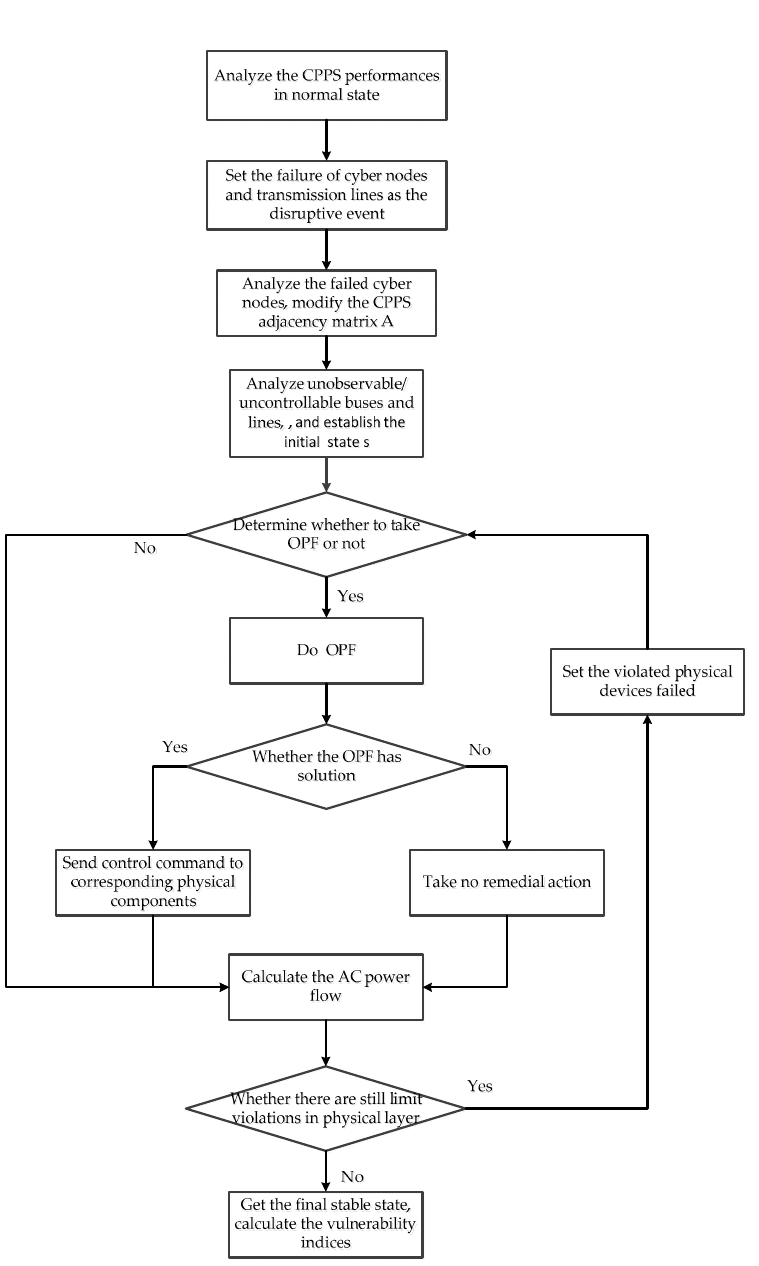
Figure 2. Flowchart of the CPPS vulnerability analysis method.